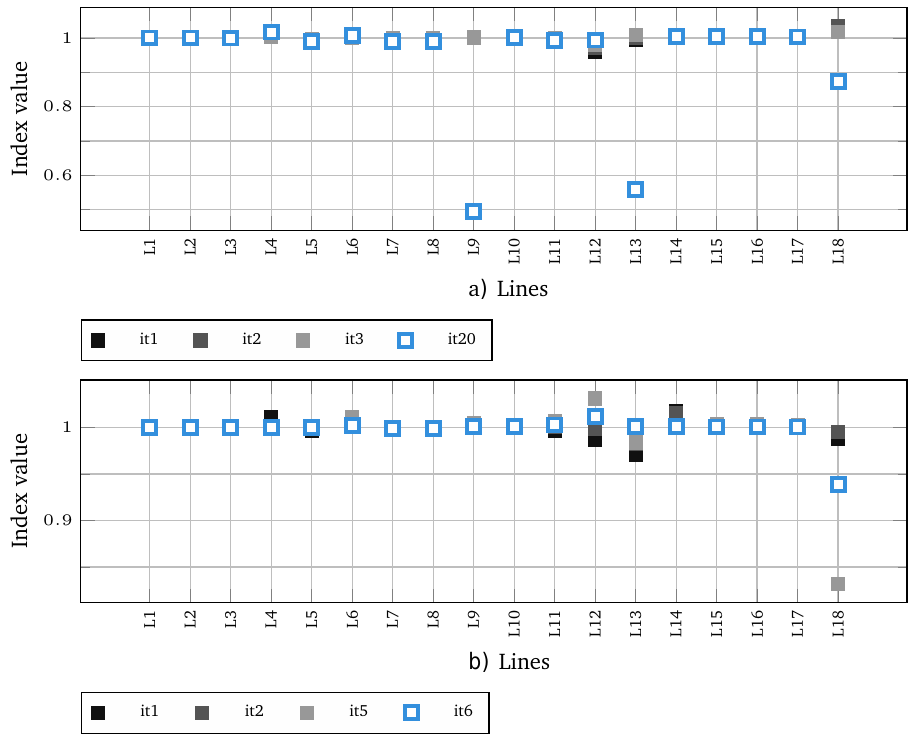
Figure 12. VSMI Index. ( a ) Frequency-dependent load model case 1. ( b ) Constant load model case